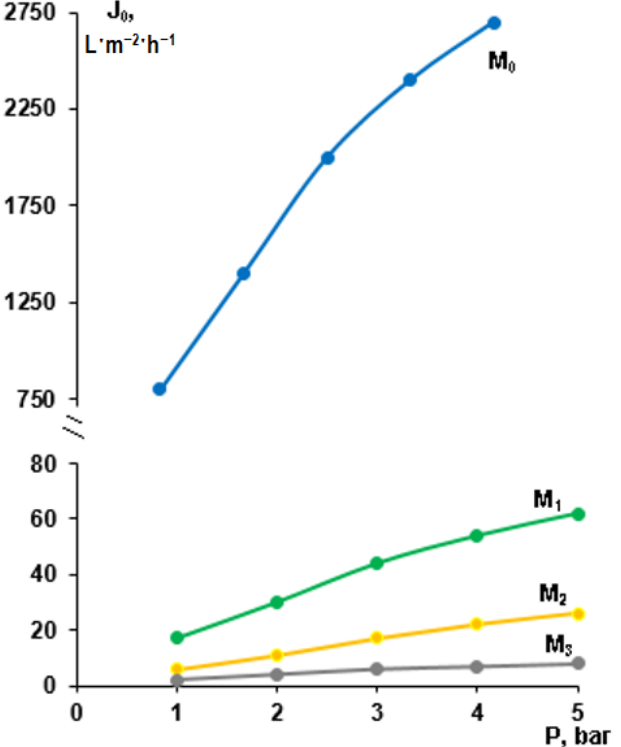
Figure 6. Pure water fluxes for initial PSf membrane (M 0 ) and membranes modified with PTFE-layer thickness 45 nm (M 1 ), 660 nm (M 2 ), and 1350 nm (M 3 ).